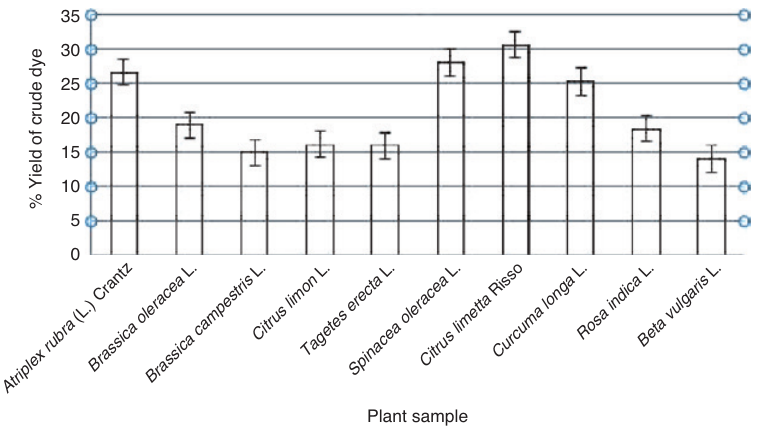
Figure 2: Determination of percent yield of crude dyes from different natural sources.